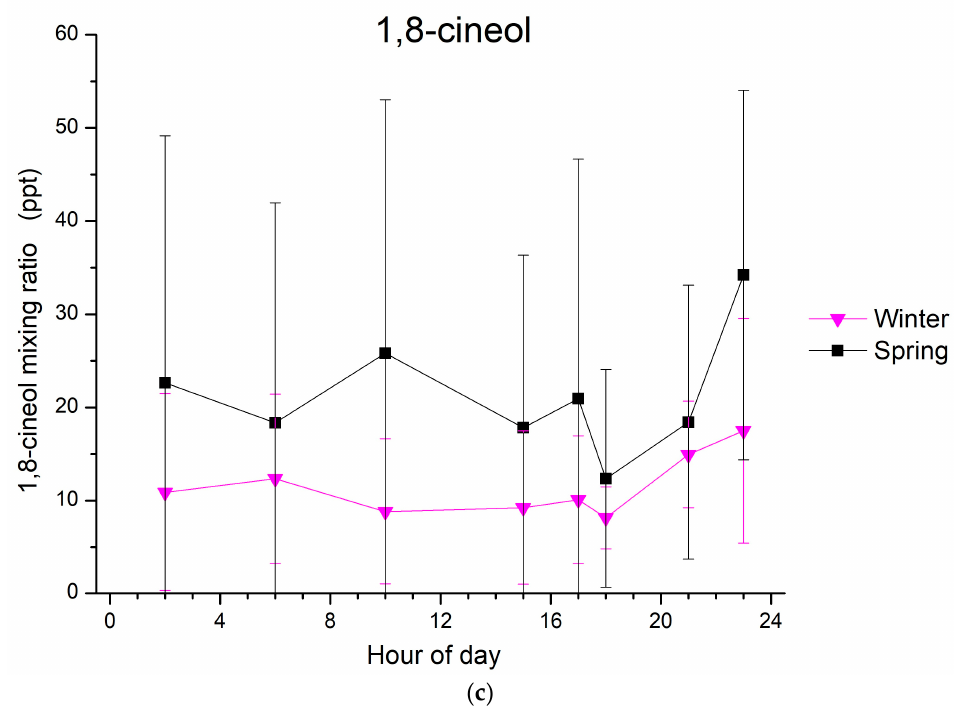
Figure 2. Diurnal average variation in mixing ratios (in ppt) of ( a ) limonene, ( b ) α -pinene and ( c ) 1,8-cineol at Finokalia station during spring (in black), summer (in red), autumn (in blue) and winter (in purple) from March 2014 to April 2015; time is at local wintertime (UTC + 2). Whiskers represent the standard deviations.